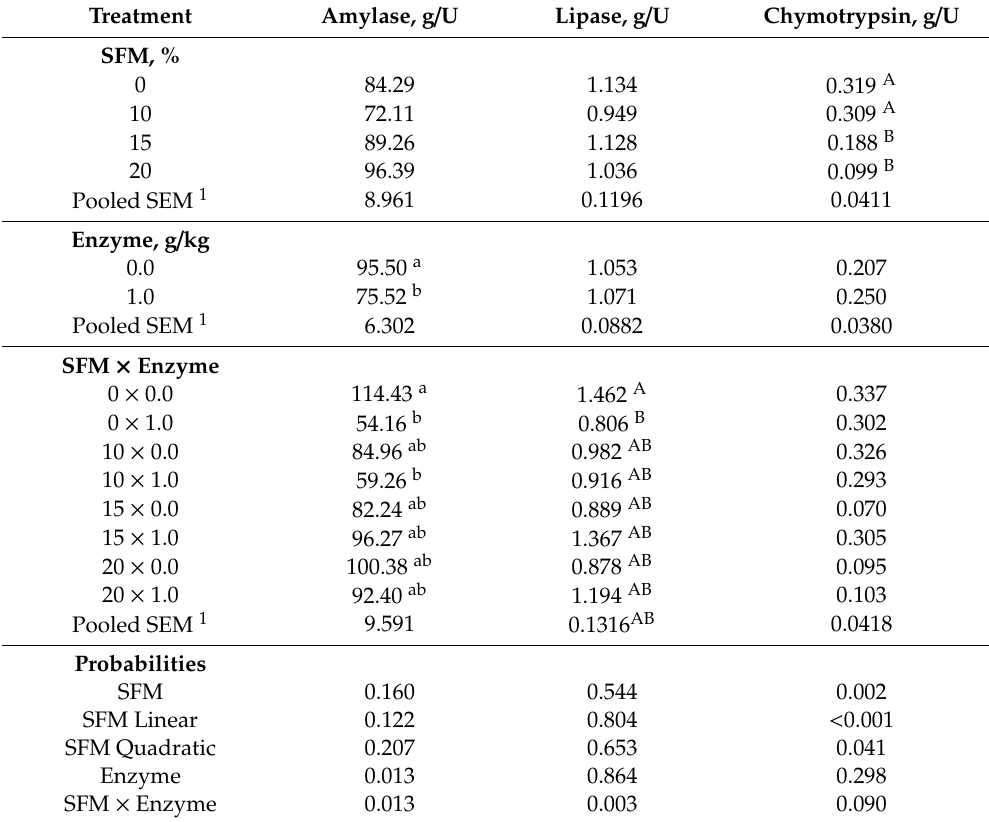
Table 5. Influence of SFM and multi-enzyme supplementation in the diet on the enzyme activities of the pancreas in growing quails